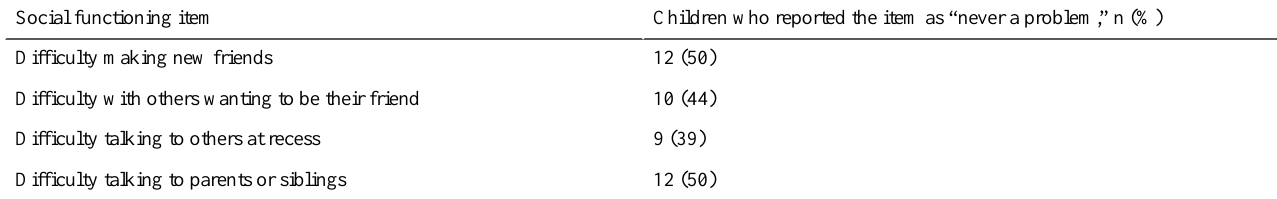
Table 5. Children’s reporting on social functioning using the Pediatric Quality of Life Inventory